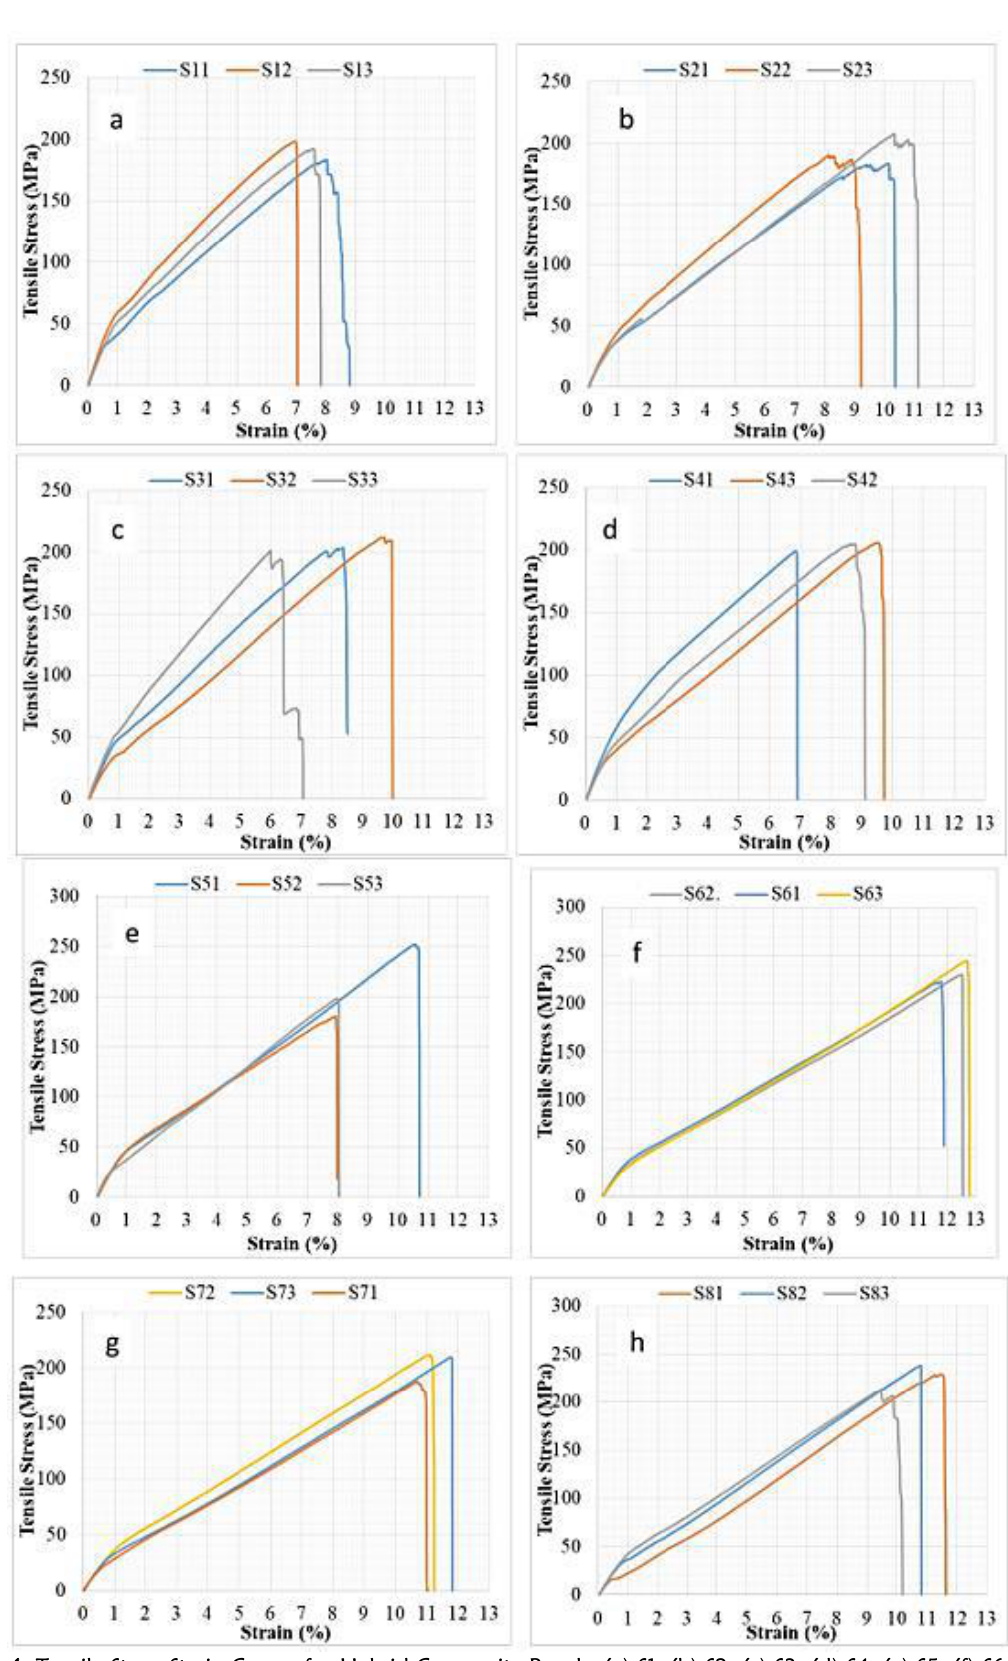
Figure 4: Tensile Stress Strain Curves for Hybrid Composite Panels: (a) S1, (b) S2, (c) S3, (d) S4, (e) S5, (f) S6, (g) S7 and (h)